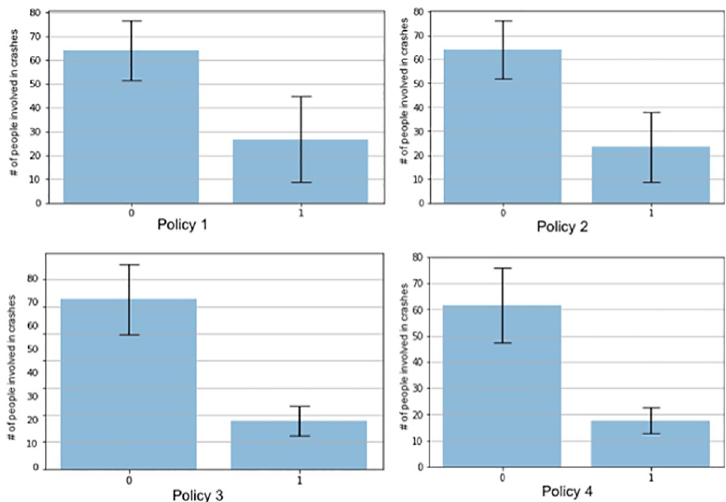
Fig 2. T-test results for four different control policies implemented in New York City during COVID-19 pandemic.